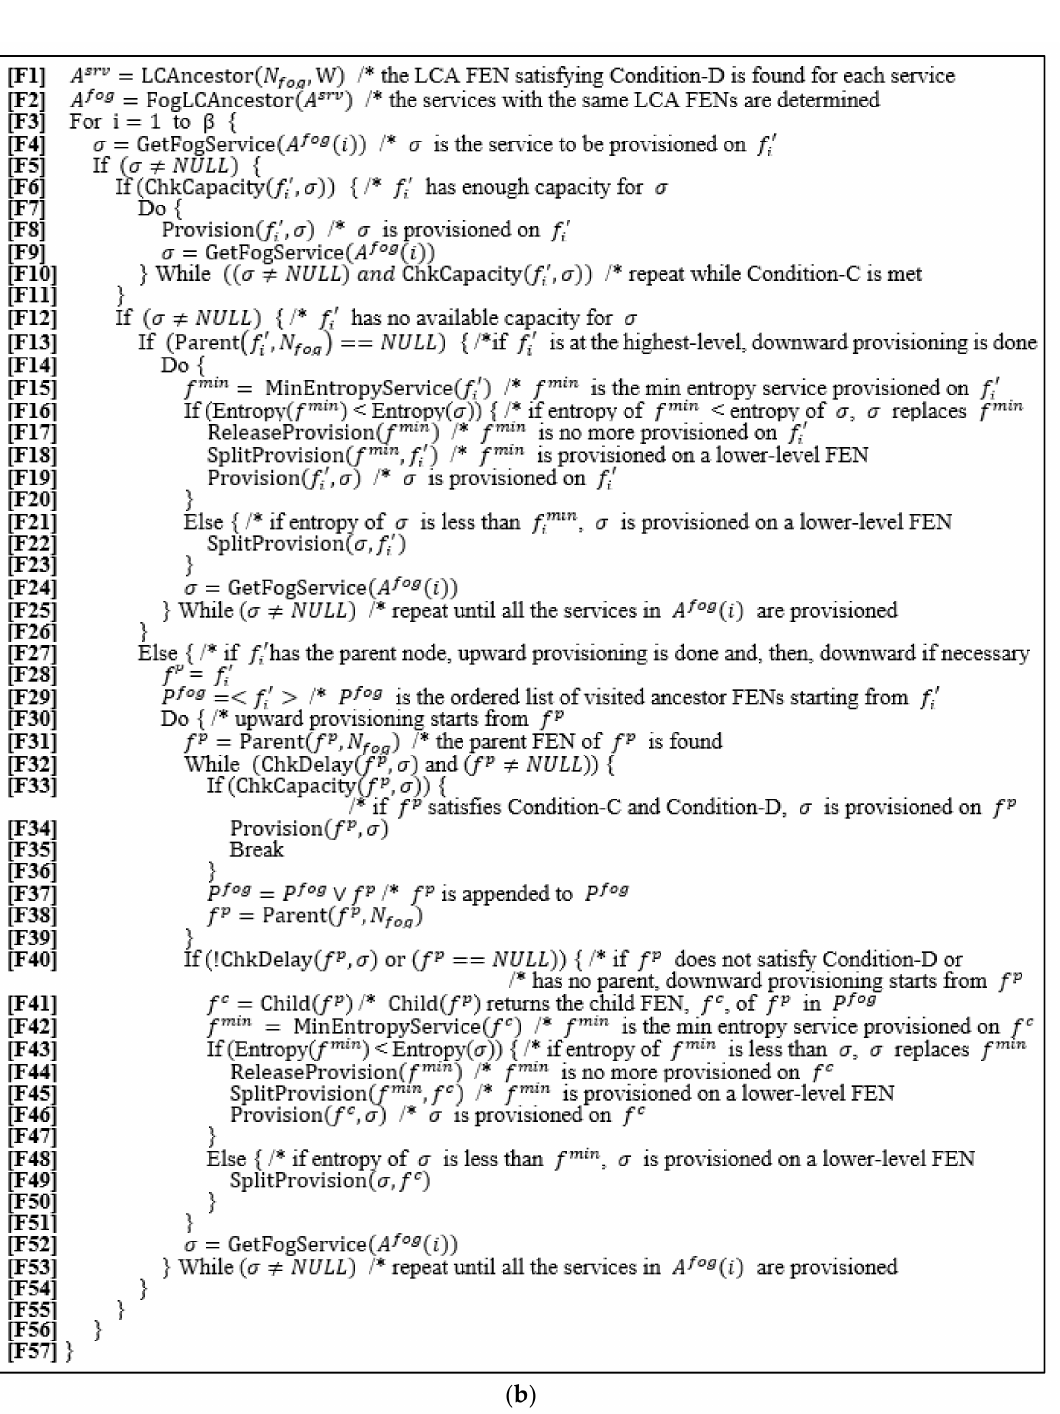
Figure 4. The procedure of the FC-SP mechanism: ( a ) described in flowcharts; and ( b ) described in pseudocode. w ij , z i ∈ Z. The elements in Z are sorted The total demands on s i is z i = ∑ j ∈{ 1,..., β } in the decreasing order, resulting in the sorted list ˘ Z . The corresponding service list of ˘ Z is ˘ S = ˘ s 1 , . . . , ˘ s α . For each service ˘ s i in ˘ S , the LCA FEN satisfying Condition-D is (cid:16) (cid:17) N fog , W determined by the function LCAncestor and the ordered list of the LCA FENs for ˘ S is A srv . Then, the function FogLCAncestor ( A srv ) returns A fog whose i th element, A fog ( i ) , is the ordered list of the services, in the decreasing order, whose LCA FEN is f (cid:48) (cid:16) (cid:17) A fog ( i ) GetFogService in [F9] returns a service (the current to-be-provisioned service σ